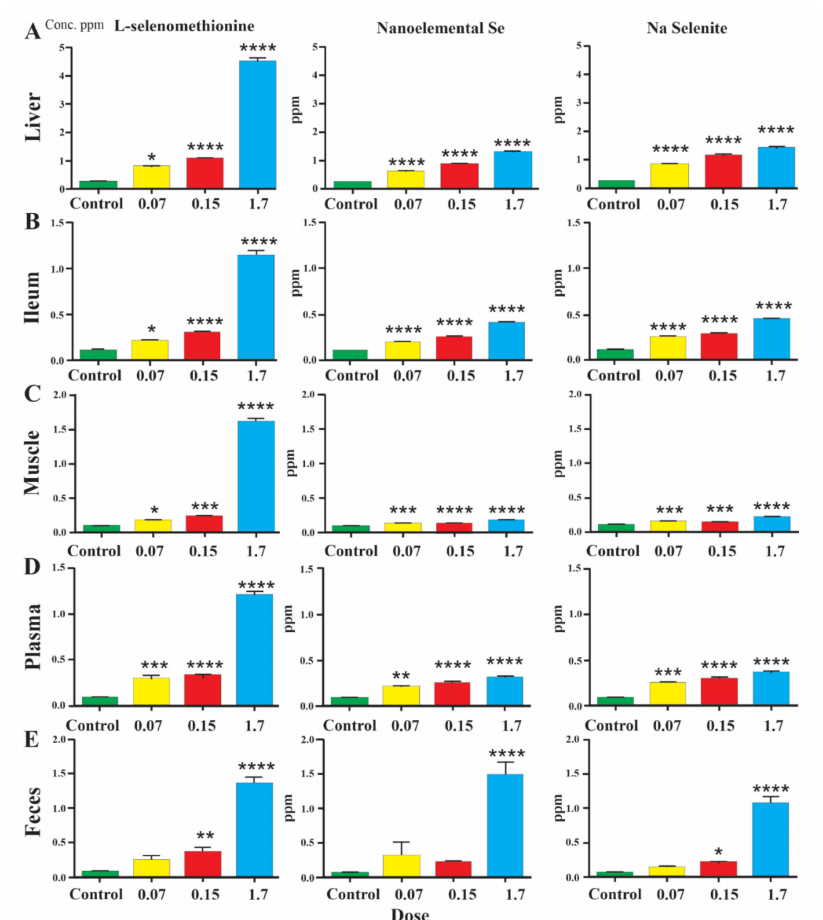
Figure 1. Comparisons of Se distributions in liver ( A ), ileum ( B ), muscle ( C ), plasma ( D ) and feces ( E ) after 5 weeks on control or Se enriched diets, plotted as concentration (parts per million, ppm) measured by mass spectrometry. Distribution of Se in liver, ileum, muscle, plasma and feces were compared relative to the control fed group of animals, i.e., minimal Se diet (0.018 ppm). One-way ANOVA was carried out with Tukey’s multiple comparisons between groups. Data is presented as mean ± SEM. p < 0.05 *, p < 0.01 **, p < 0.001 ***, p < 0.0001 ****, relative to